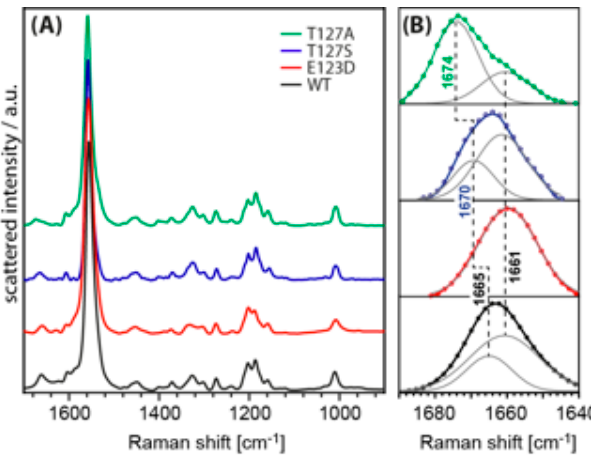
Figure 5. ( A ) Resonance Raman spectra of Cr ChR2-WT and the variants E123D, T127S, and T127A in H 2 O. ( B ) Zoom-in of the frequency range of the Schi ff base vibration after a three-point moving average smooth. Blue circles are the data points. Dashed grey lines are Gaussians fitted to the data points and continuous lines are sums of the fitted